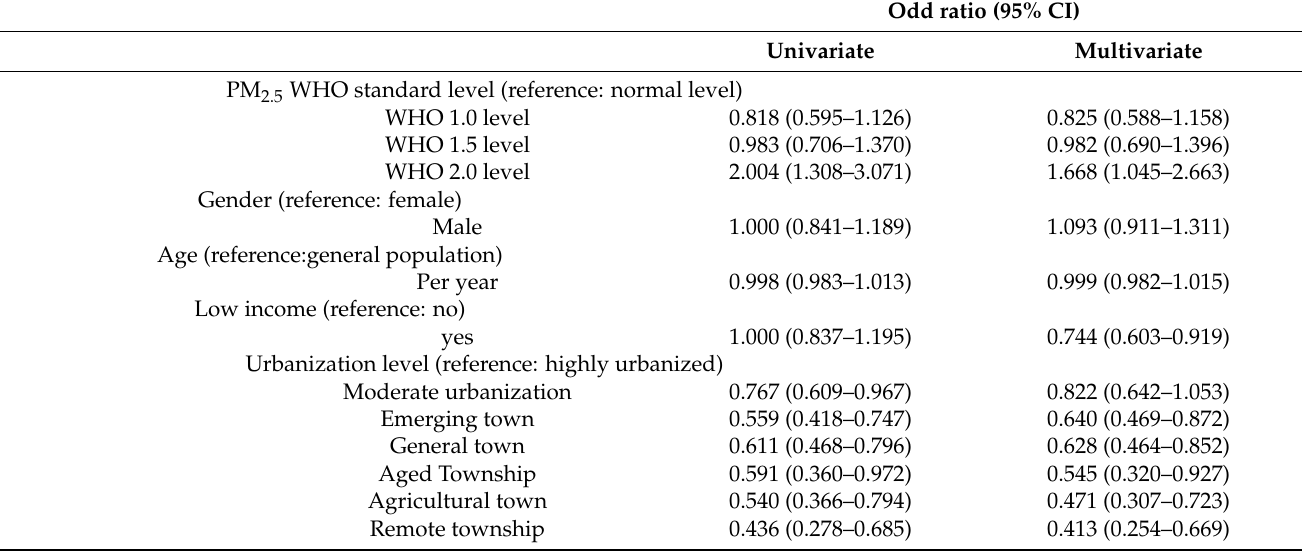
Table 3. Logistic regression analysis of PM 2.5 level and